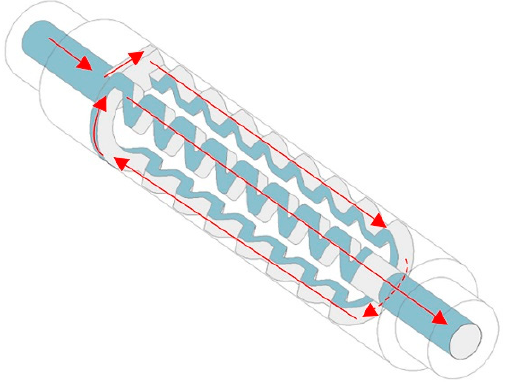
Figure 2. Axonometric diagram of the movement route of the water in the flow channel (the red arrow).